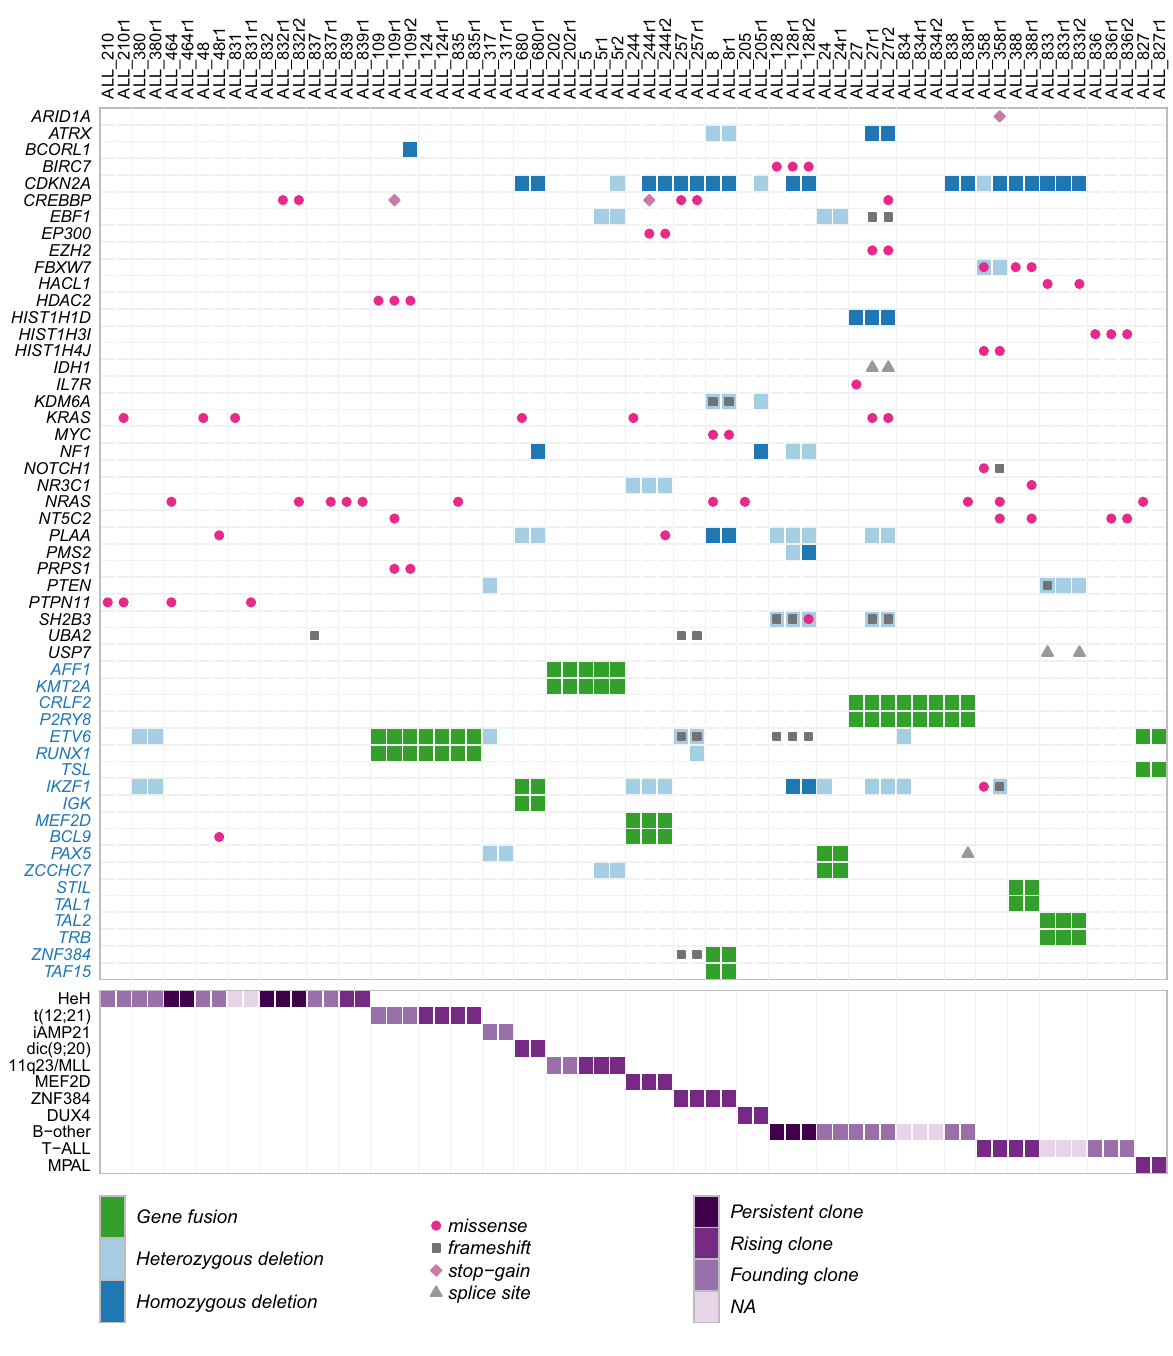
Figure 4. Distribution of somatic driver mutations, copy number losses and gene fusions at diagnosis and relapse. Genes are included in the figure if they were defined as driver genes in the present study based on somatic SNVs and indels (gene acronyms in black), or if they are listed in the OncoKB database and contain copy number loss in at least one analysed sample (gene acronyms black), or if they are part of gene fusions that define ALL subtypes (fusion partner gene acronyms in blue). Columns represent samples at diagnosis and relapse(s) from the 29 ALL patients. Sample names are shown above the top panel, and genetic subtypes as well as the assigned trajectories of clonal evolution are indicated in the bottom panel. The type of genomic alteration detected in each sample is color coded as indicate at the bottom of the